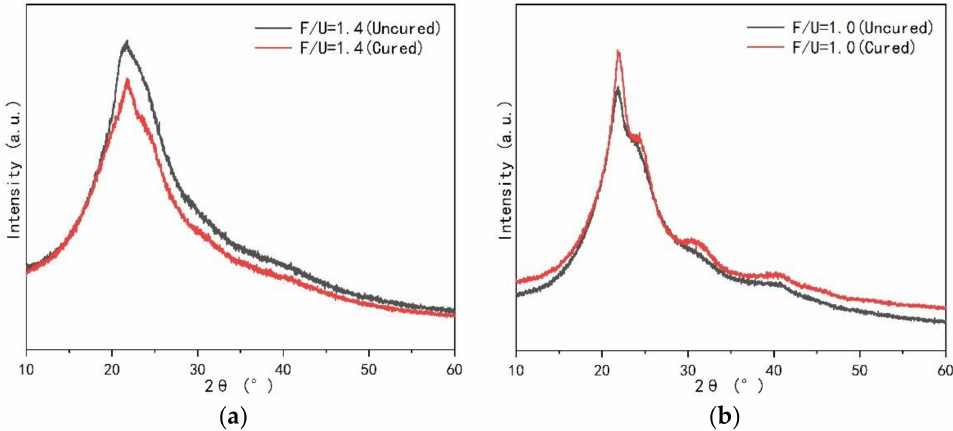
Figure 2. X-ray diffraction (XRD) patterns of UF resin with different molar ratios (F/U) before and after curing. ( a ) F/U = 1.4, ( b ) F/U = 1.0.